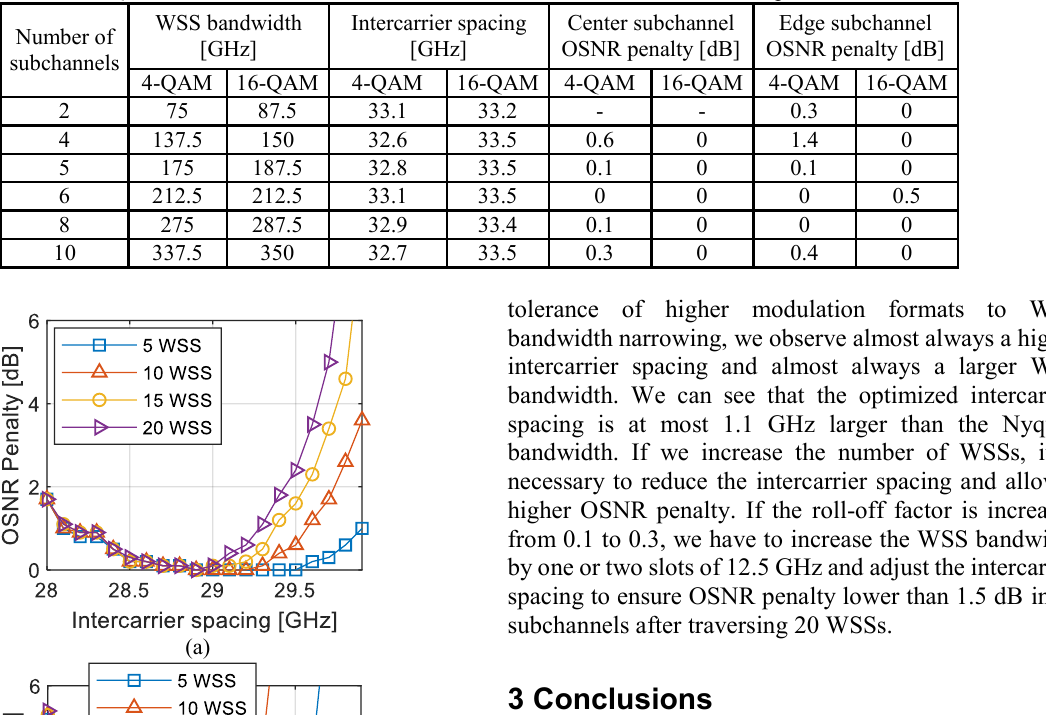
Table 2. Intercarrier spacing and the lowest OSNR penalty after 20 cascaded WSSs for 32.5 GBd with 𝜌 =0.1, 4-QAM and 16-QAM modulation formats, for a different number of subchannels in the superchannel.